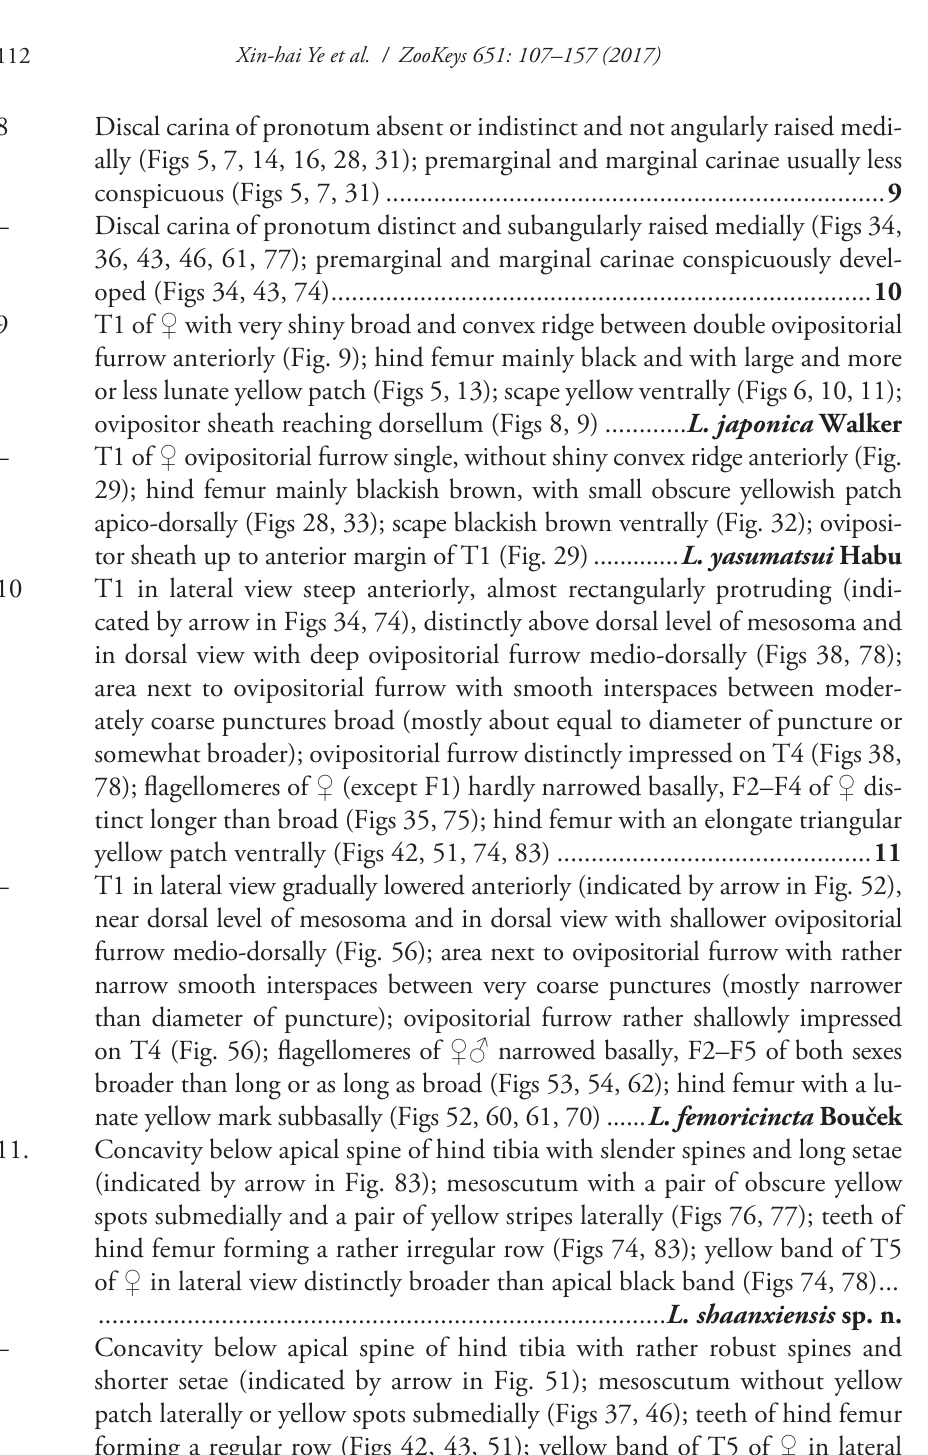
Concavity below apical spine of hind tibia with slender spines and long setae (indicated by arrow in Fig. 83); mesoscutum with a pair of obscure yellow spots submedially and a pair of yellow stripes laterally (Figs 76, 77); teeth of hind femur forming a rather irregular row (Figs 74, 83); yellow band of T5 of ♀ in lateral view distinctly broader than apical black band (Figs 74, 78)